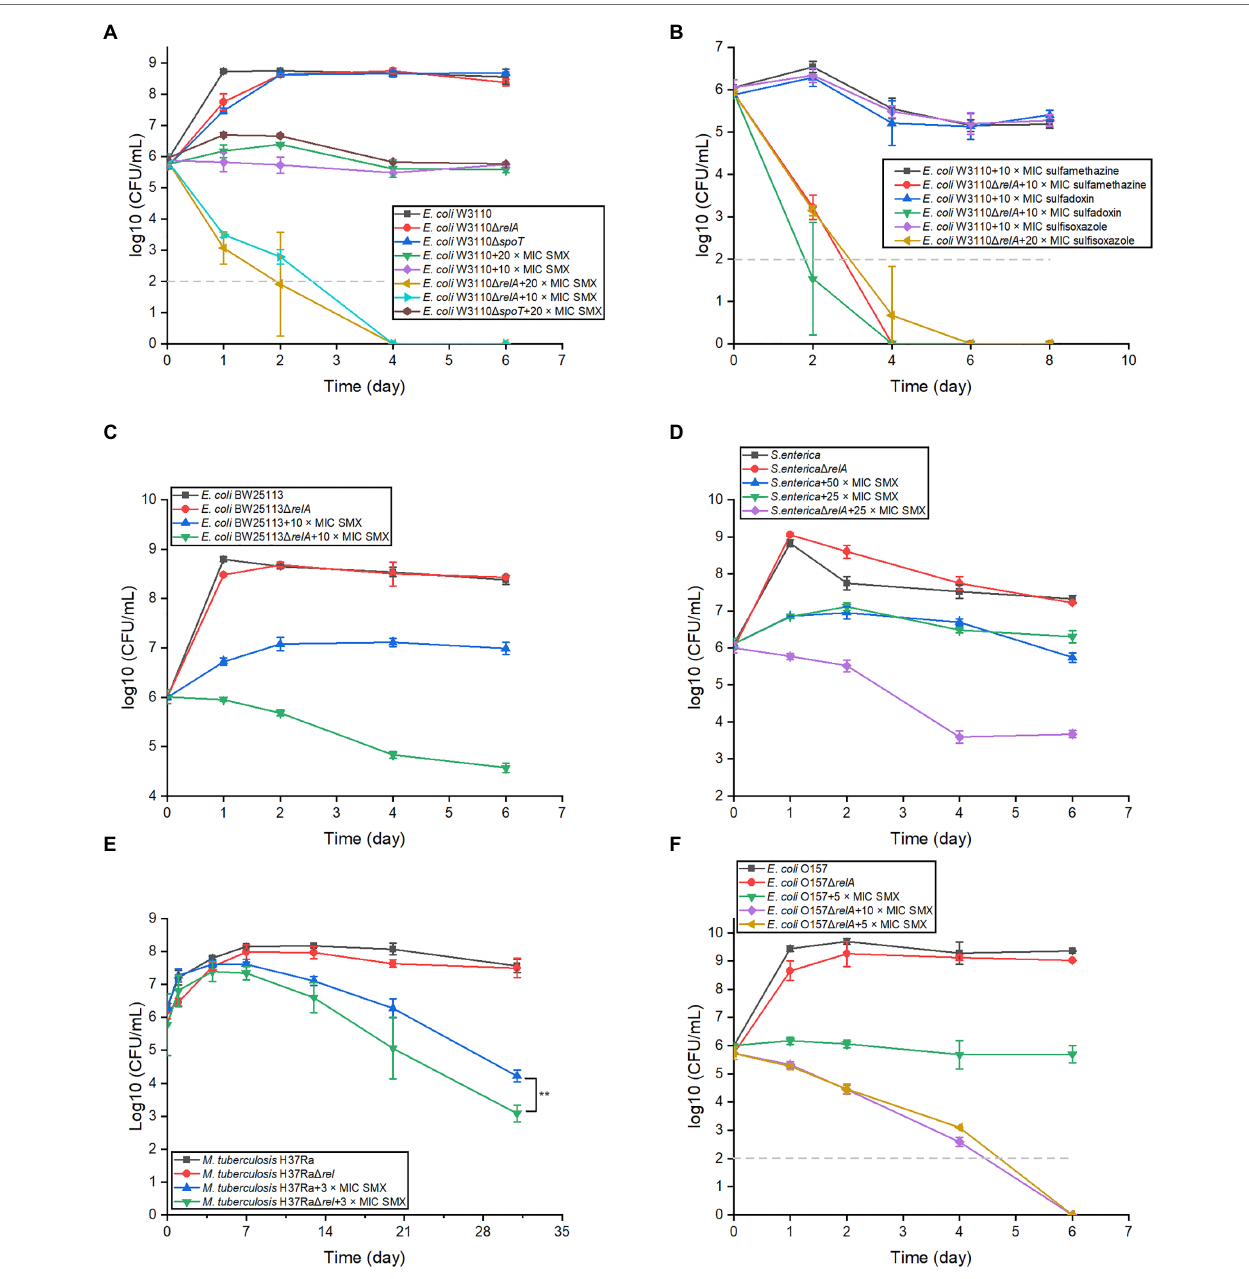
FIGURE 1 | Disrupting the stringent response in different bacterial species converts sulfonamides into bactericides. (A) Two key stringent response genes show disparate effects on the bactericidal effect of SMX in Escherichia coli . (B) Inactivation of relA in E. coli W3110 also converts other sulfonamides into bactericides, including sulfamethazine (80 μ g/ml), sulfadoxin (80 μ g/ml) and sulfisoxazole (40 μ g/ml). SMX shows bactericidal effect on E. coli BW2511 ∆ relA (C) , S. typhi ∆ relA (D) , M. tuberculosis H37Ra ∆ relA (E) , and pathogenic E. coli O157 (F) . The MICs of SMX for different bacterial strains were listed in Supplementary Tables S1 and S2 . Dashed gray lines represent the limit of detection. In panel (A–D,F) , statistical analysis was determined between each ∆ relA mutant and its equivalent wild type with SMX treatment at each time point, and the differences were all statistically significant ( p < 0.001). Statistical analysis was determined by unpaired two-tailed Student’s t test (* p ≤ 0.05, ** p ≤ 0.01, p > 0.05 is not shown). Error bars represent the standard